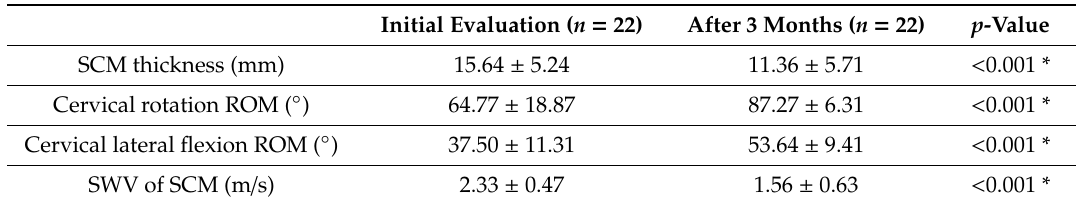
Changes in acoustic-radiation-force-impulse-measured shear-wave velocity of the sternocleidomastoid muscle, sternocleidomastoid muscle thickness, and degrees of cervical rotation and lateral flexion on the a ff ected side before and after physical therapy.